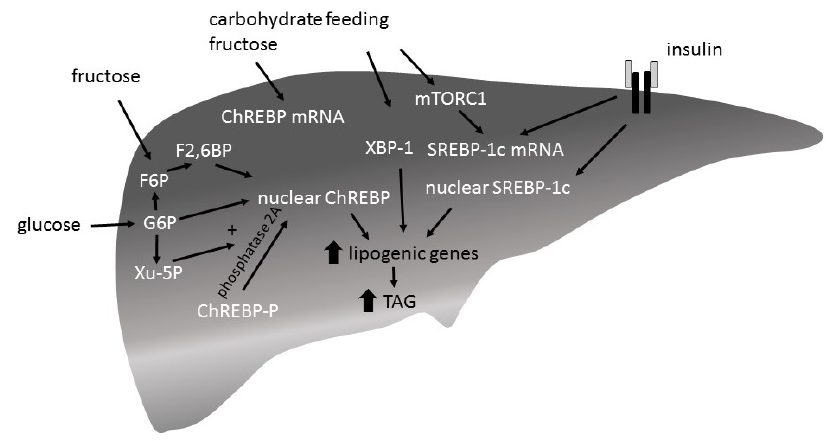
Figure 4. Carbohydrate induced expression of lipogenic genes. (1) Activation of carbohydrate responsive element binding protein (ChREBP): xylulose 5-phosphate (Xu-5P), glucose 6-phosphate (G6P), and fructose-2,6-bisphosphate (F2,6BP) promote nuclear entry of ChREBP. (2) Sterol regulatory element binding protein-1c (SREBP-1c) transcription and dependent expression of lipogenic enzymes is mediated by mechanistic target of rapamycin C1 (mTORC1) signaling. mTORC1 is induced by insulin signaling, but also directly by carbohydrate feeding. Translocation of SREBP1c depends on insulin signaling. (3) X-Box Binding Protein 1 (XBP-1) is involved in the control of lipogenic gene expression. The underlying mechansims are unknown.